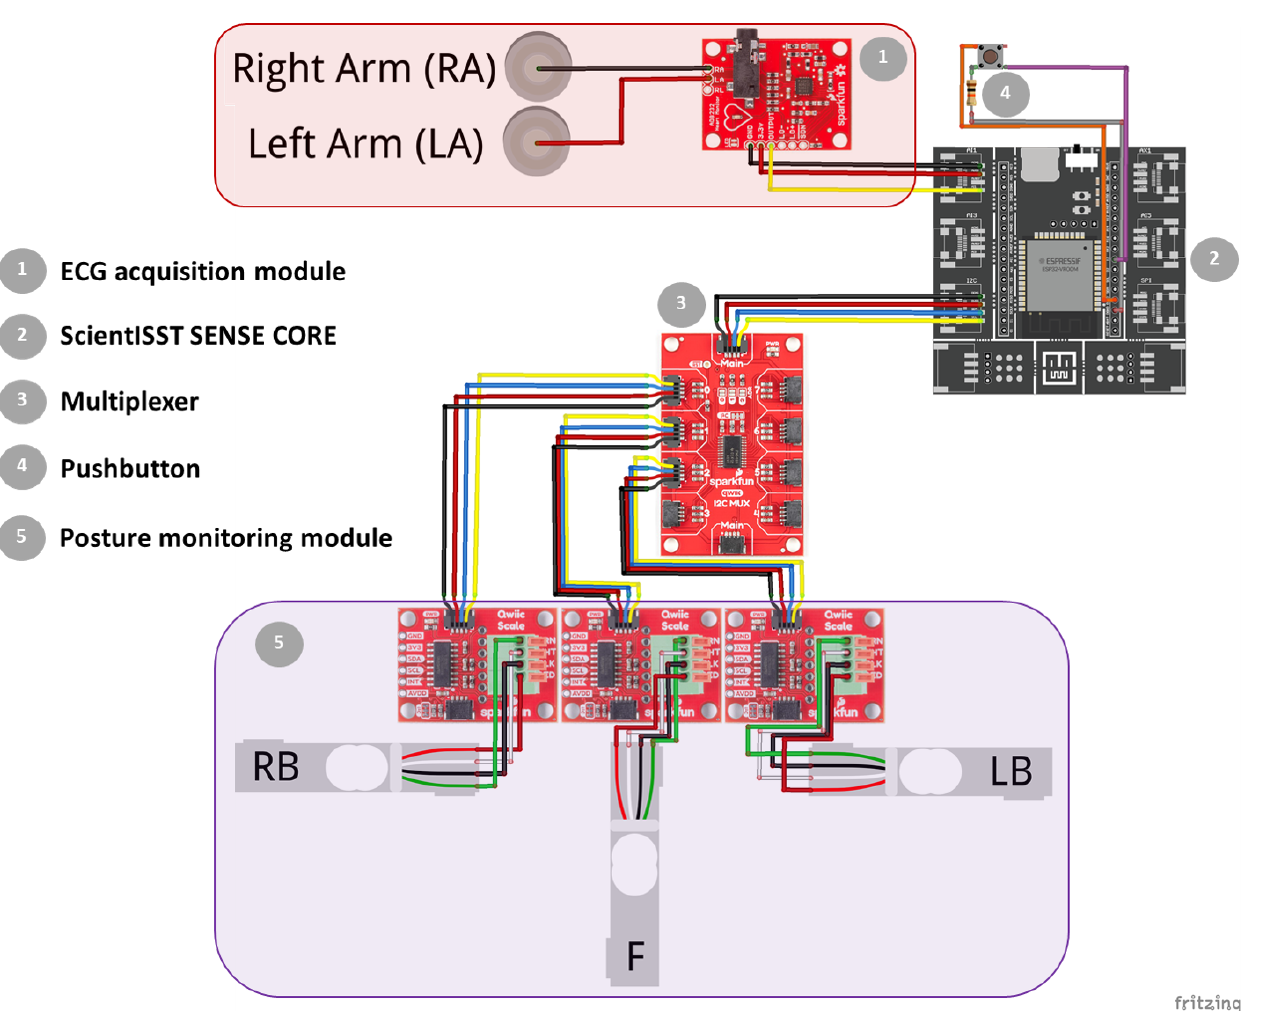
Figure 2. Diagram of the prototype’s system architecture and constituent hardware modules. Created with